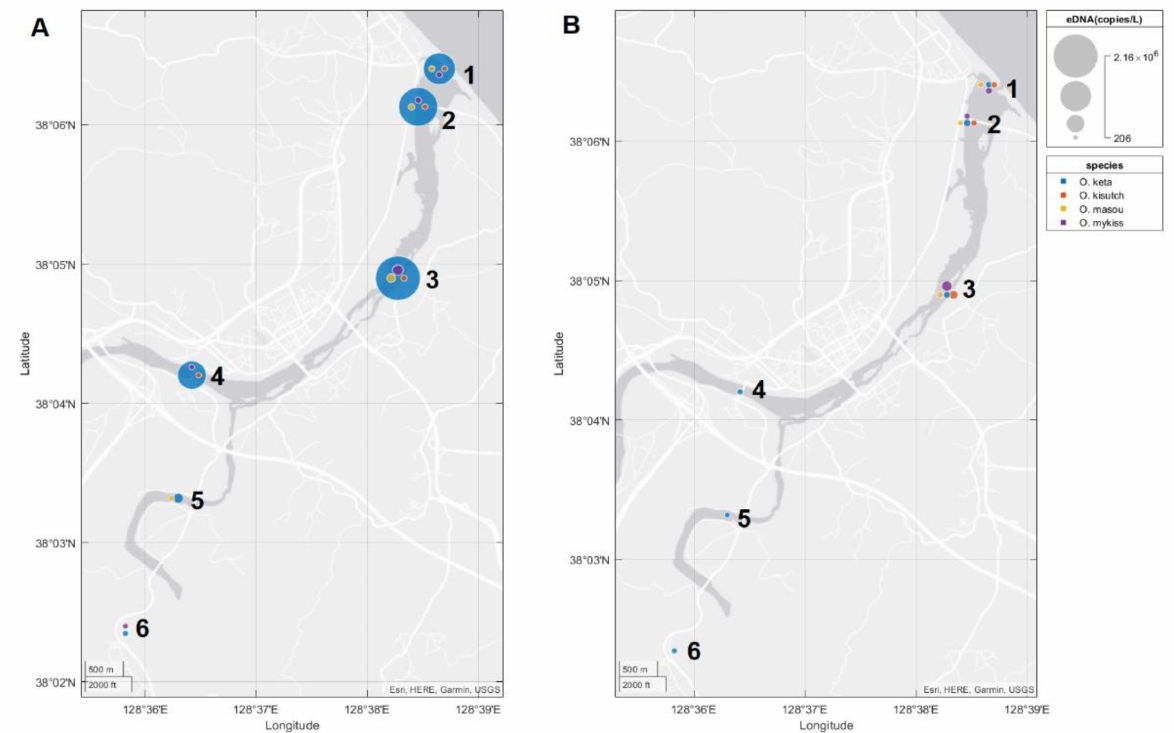
Figure 4. Mean eDNA concentration (copies/L) of four target salmon in the Yangyangnamdae River during the November ( A ) and March ( B ) sampling events. The sampling sites from the downstream are numbered.